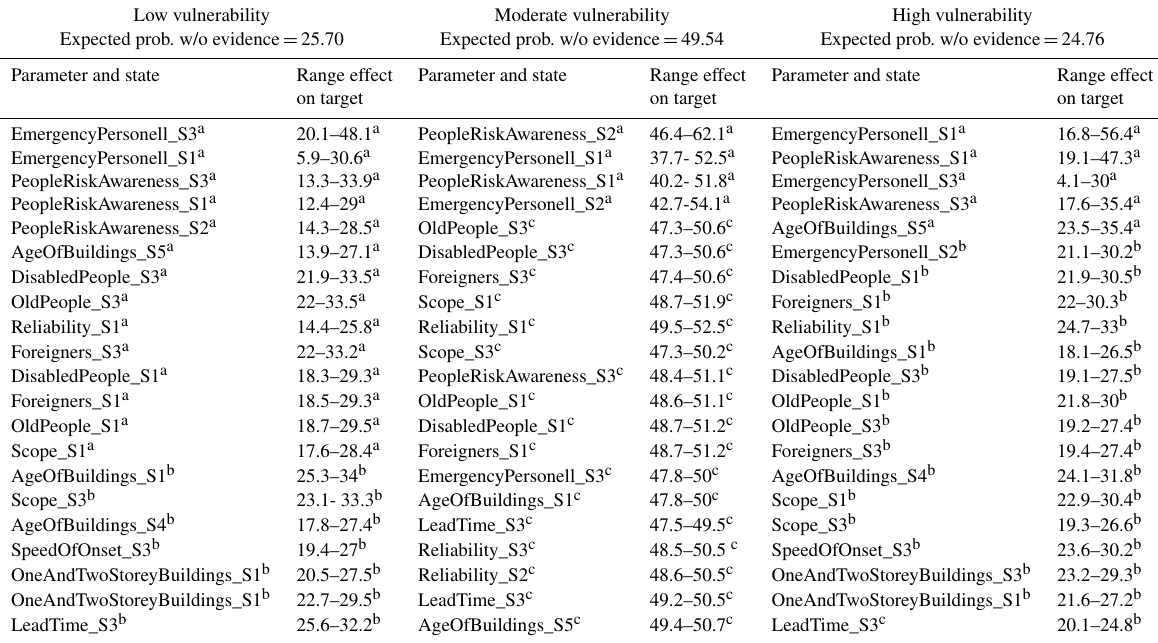
Table 2. Main sensitivities of the Bayesian vulnerability module in percentages.